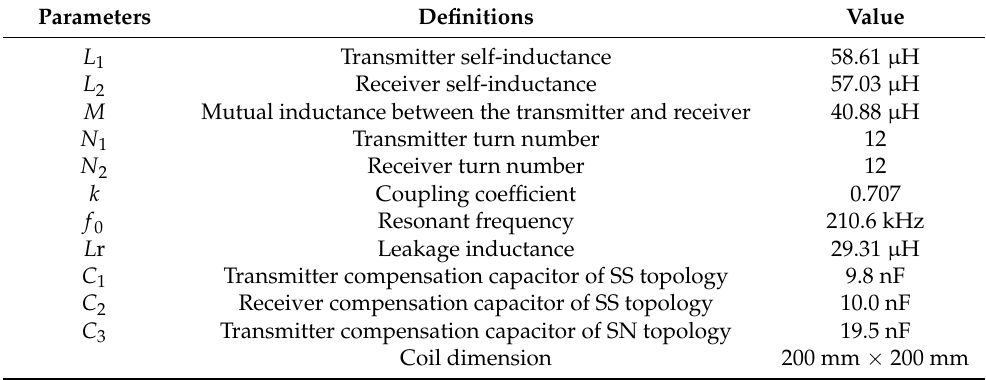
Figure 8. Experimental prototype. Table 1. System parameters.